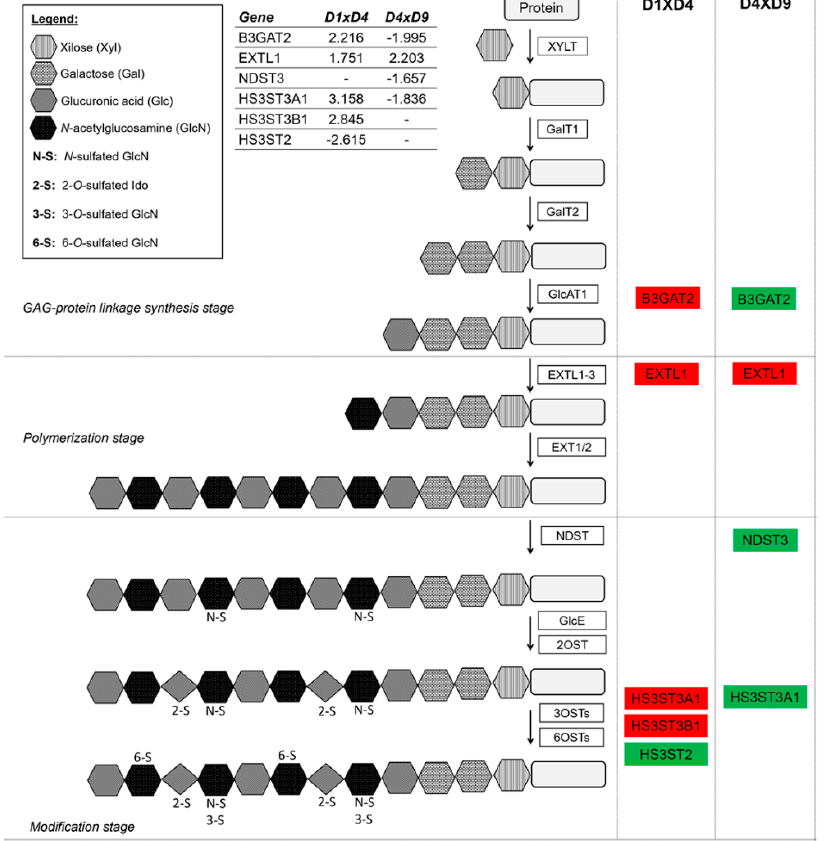
Figure 7. Differentially expressed genes involved in heparan sulfate biosynthesis. Comparison of DEGs identified in the heparan sulfate biosynthesis pathway at the mesoderm (D1 × D4) and cardiac progenitor (D4 × D9) commitment stages. Red boxes indicate upregulated genes, while green boxes indicate downregulated genes. XYLT: xylosyltransferase, GalT: galactosyltransferase, GlcAT1: glucuronic acid transferase, NDST: N -deacetylase/ N- sulfotransferase-1, GlcE: glucuronic acid epimerase, 2OST: 2-O-sulfotransferase, 3OST: 2-O-sulfotransferase, 6OST: 2-O-sulfotransferase (adapted from